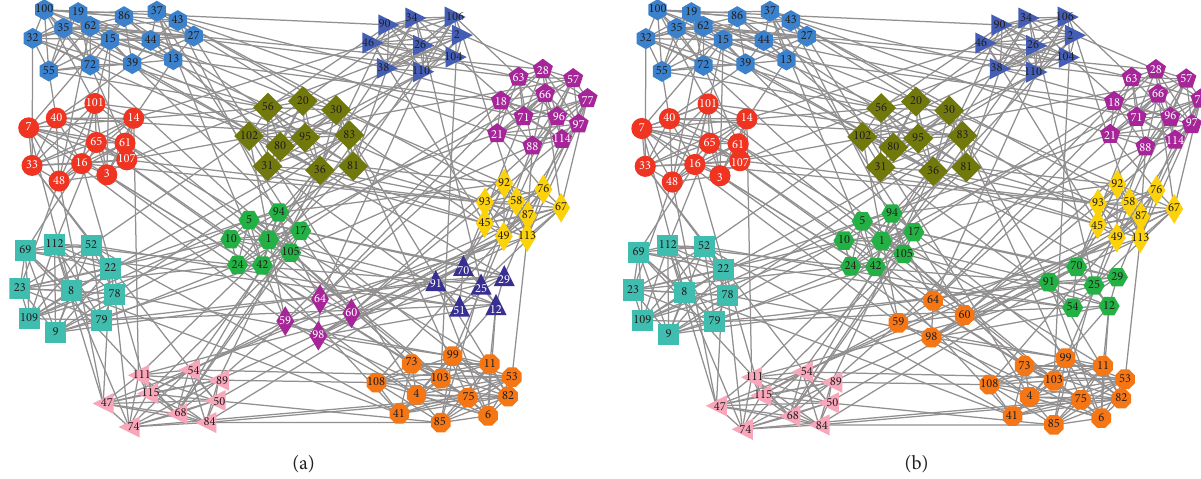
Figure 4: The network of college football game schedule. (a) The ground-truth community structure. (b) The community structure detected by our proposed